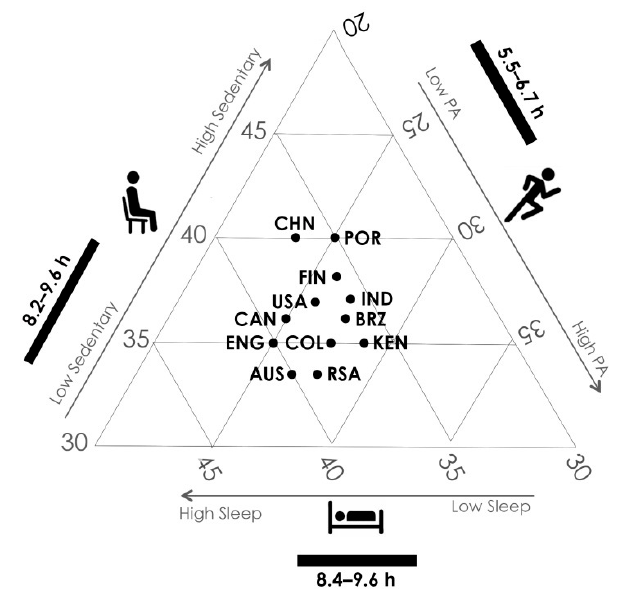
Figure 4. Ternary plot of the average proportions of the 24-h day spent in sleep (bottom axis), sedentary behaviour (left axis) and total physical activity (right axis) in the 12 ISCOLE countries. The black bars represent the range of time (h / day) spent in the various movement behaviours. For sedentary behavior, follow the direct horizontal line to the left axis; for physical activity, follow the lines sloping upwards from left to right to the right axis; for sleep, follow the lines sloping downwards from left to right to the bottom axis. Chinese (CHN) children, for example, spend on average 37% of the day sleeping, 40% of the day sedentary and 23% in physical activity. Compositional means are from Dumuid et al. [70]. AUS = Australia; BRZ = Brazil; CAN = Canada; CHN = China; COL = Colombia; ENG = England; FIN = Finland; IND = India; KEN = Kenya; POR = Portugal; RSA = Republic of South Africa; USA = United States.